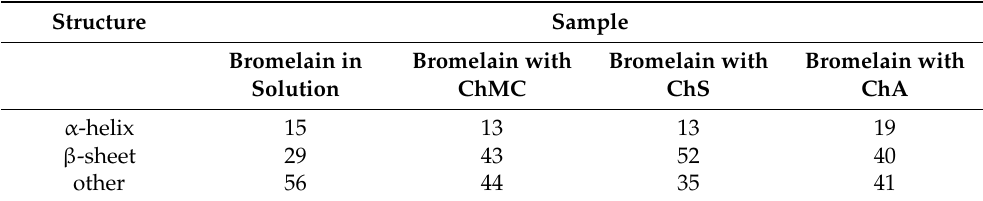
Figure 5. Amide I spectra of bromelain and chitosan derivative complexes are normalized to the maximum. Table 2. Secondary structure (in%) of bromelain immobilized on chitosan derivatives: ChMC, ChS, and